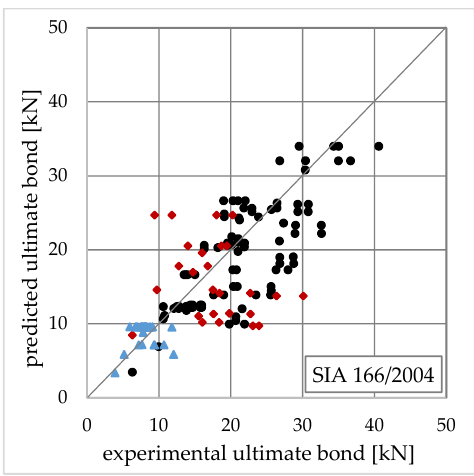
Figure 22. Test vs. predicted bond force using the JCI 2003 model [35].